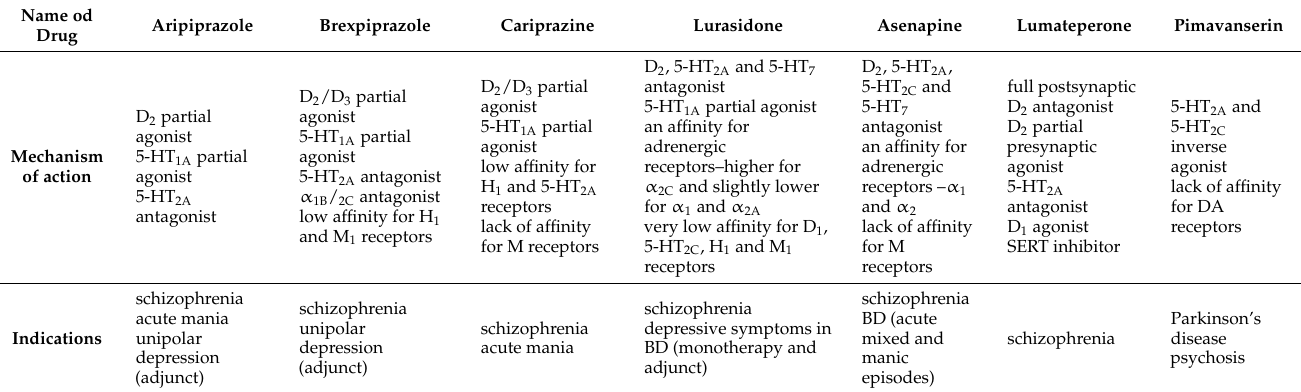
Table 1. The characteristics (mechanism of action and indications) of the antipsychotics